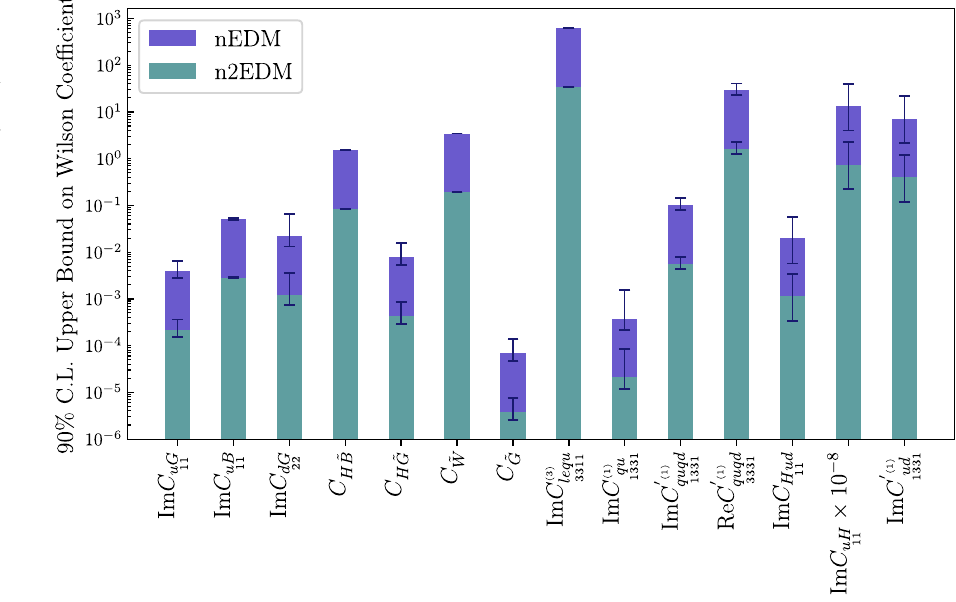
Fig. 6 Selected upper bounds on the Wilson coefficients, assuming (cid:2) = 5 TeV and applying the rescalings shown in Table 3, obtained including the full 1-loop expressions, from the experimental bounds on the neutron EDM. In addition to the bounds from the central values, we also show the influence of the uncertainties in the determination of the chromo-dipole and Weinberg operator matrix elements. We also show bounds on the Wilson coefficients for the projected accuracy of the n2EDM experiment. Notice that the last two Wilson coefficients are in the up-quark gauge basis, while the others in the mass